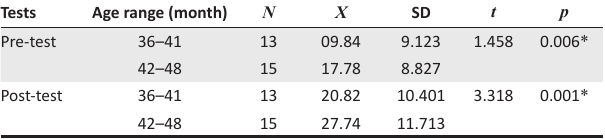
TABLE 5: The experimental group’s Brief Infant-Toddler Social and Emotional Assessment pre- and post-test scores by